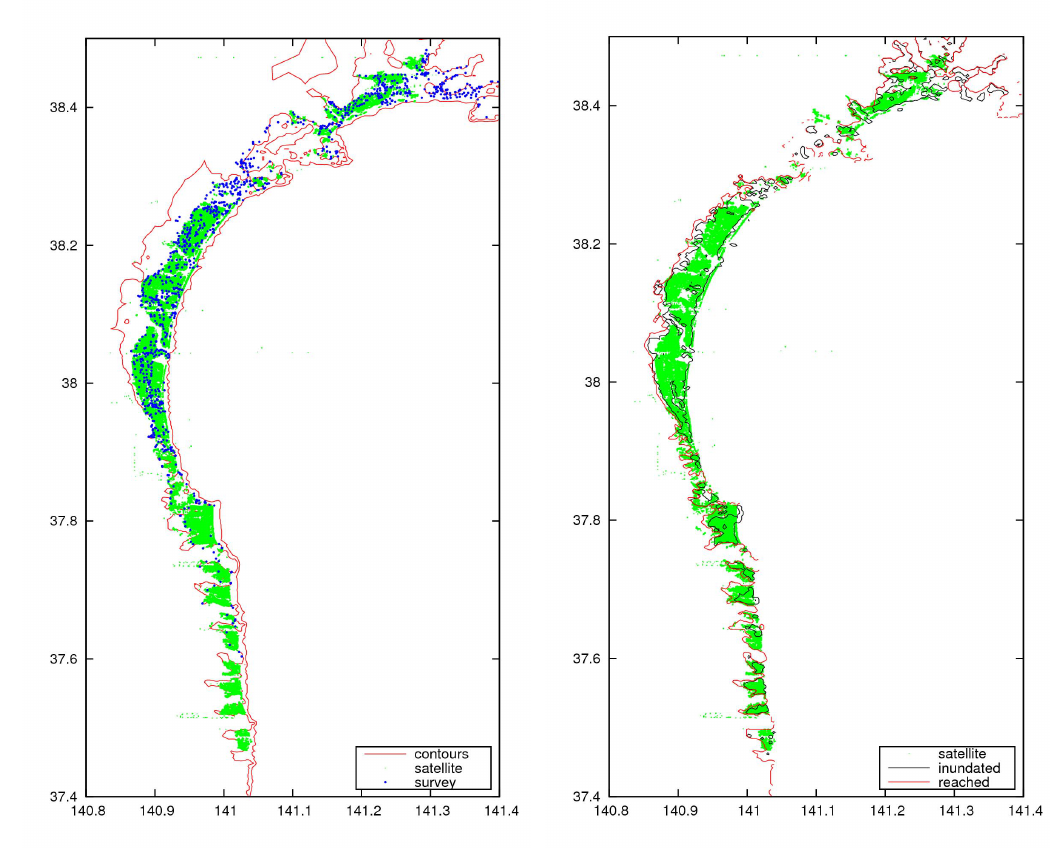
Fig. 15. Maps of inundation extent for the Miyagi prefecture area. Left: 0 and 10m contours (red), SAR estimate of inundation extent on 12 March 2011 (green), field survey data points (blue). Right: SAR inundation estimate (green), maximum modelled inundation extent (red) and modelled inundated areas at t = 10h (black).